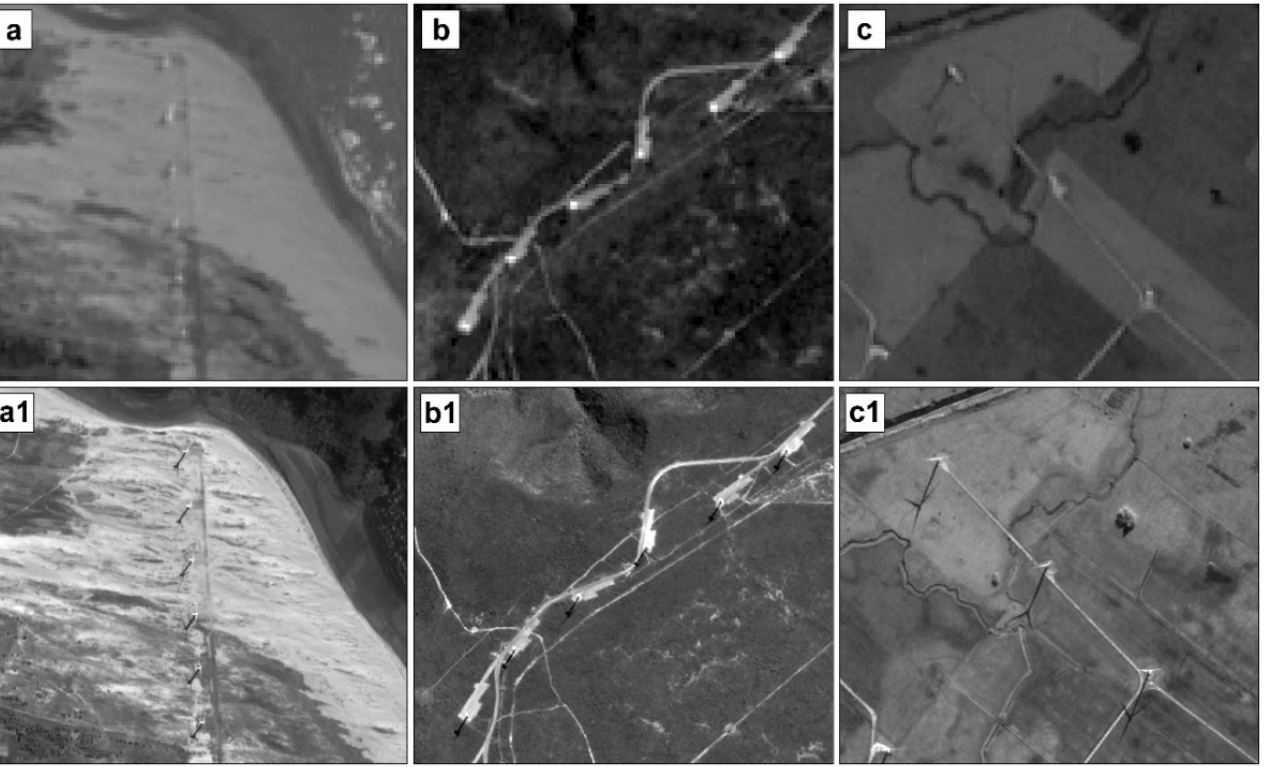
Figure 3. Example of the shadows produced by the wind plants considering Sentinel ( a – c ) and CBERS 4A images ( a1 , b1 , c1 ).